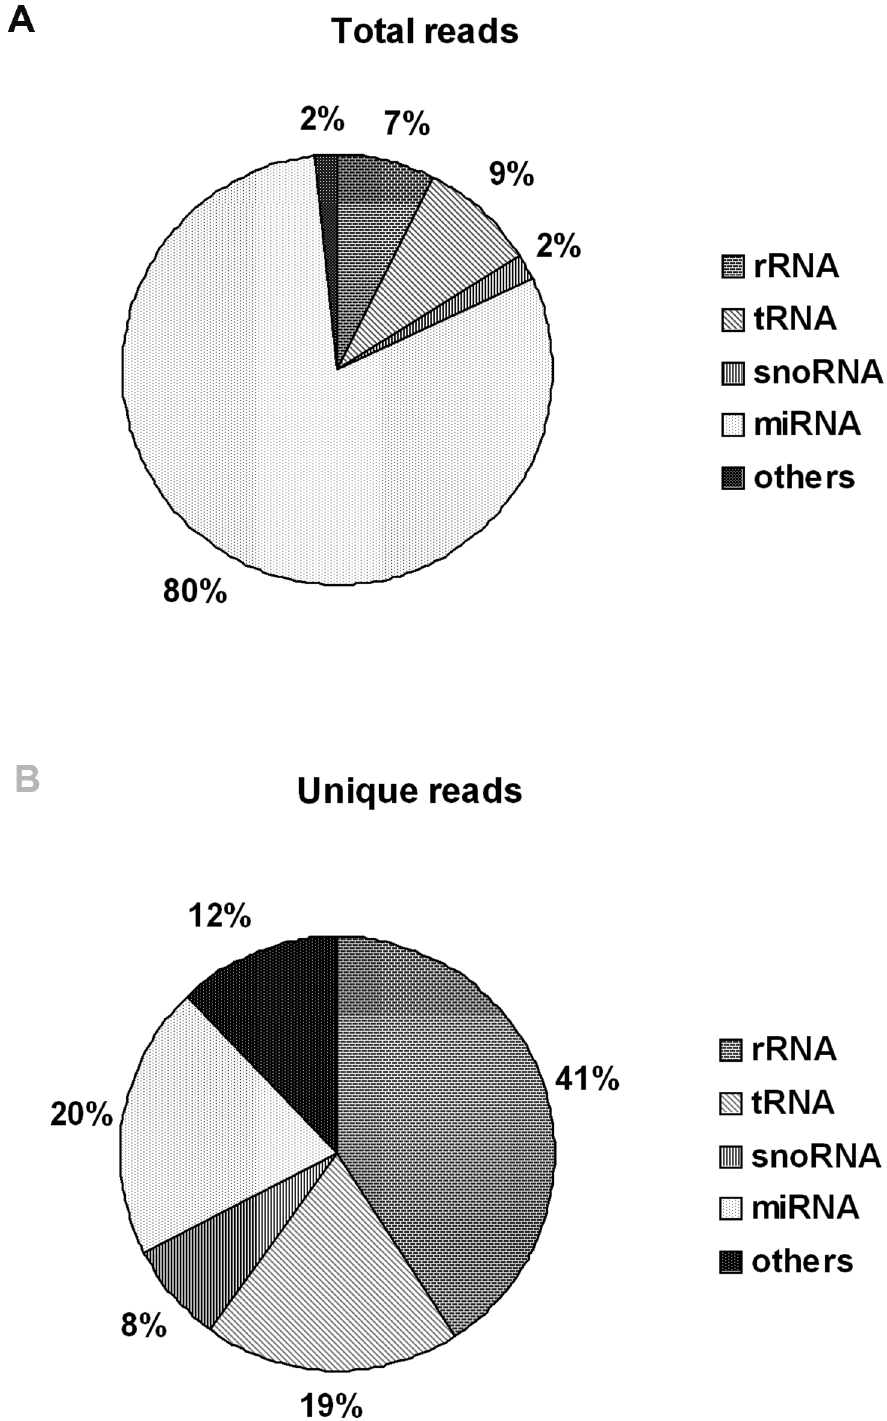
Figure 3. Annotation of small RNA sequences. (A) Annotation of total sequence reads. (B) Annotation of unique sequence reads.